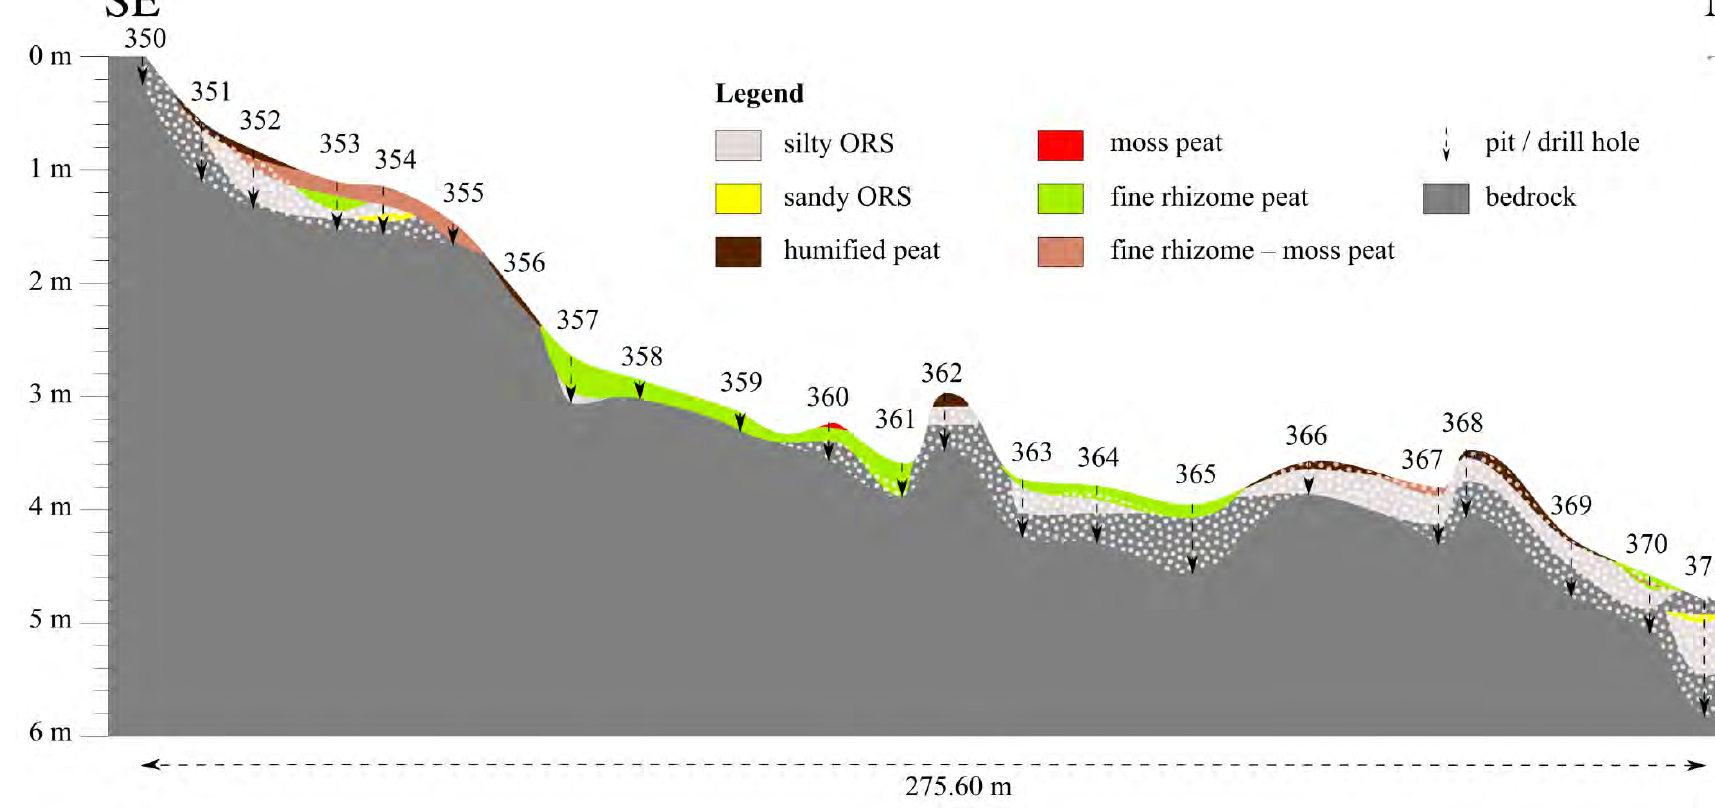
Figure 11. Stratification of the Čatyr-Kël' Peatland. White dots mark layers which contain